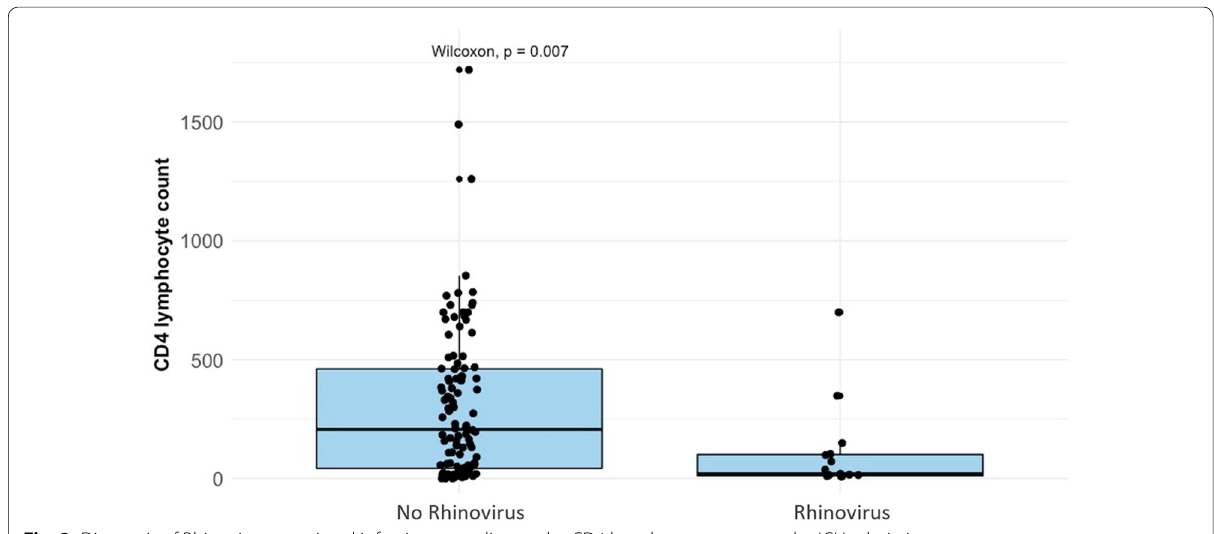
Fig. 2 Diagnosis of Rhinovirus‑associated infection according to the CD4 lymphocyte count on the ICU admission